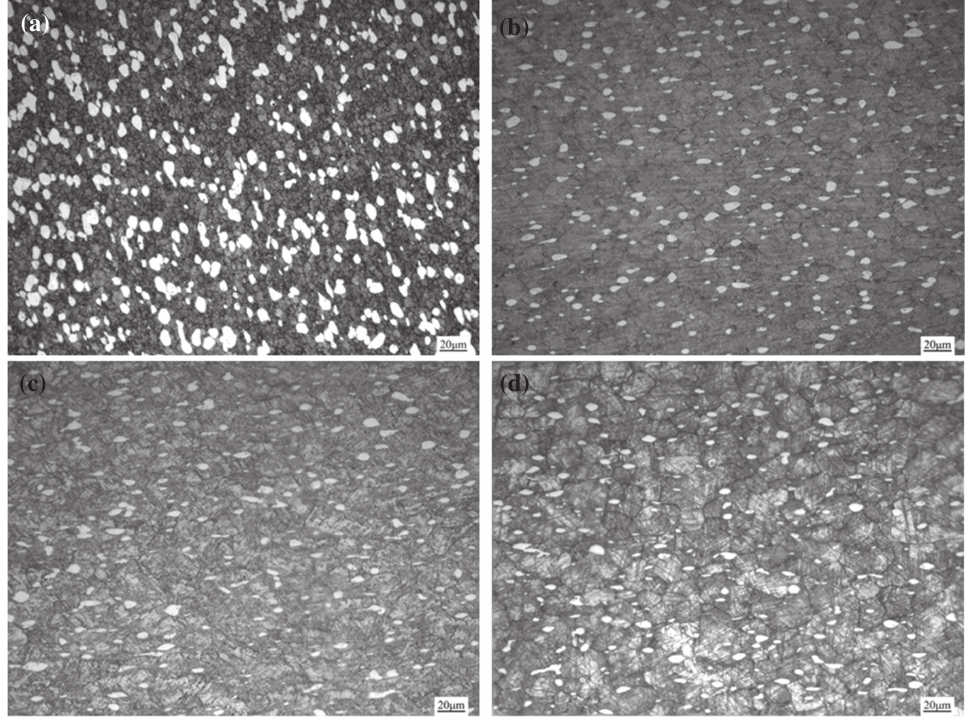
Figure 15: Microstructures under the deformation temperature of 1,213 K and strain rates of: (a) 1.0 s – 1 ; (b) 0.1 s – 1 ; (c) 0.01 s – 1 ; (d) 0.001 s – 1